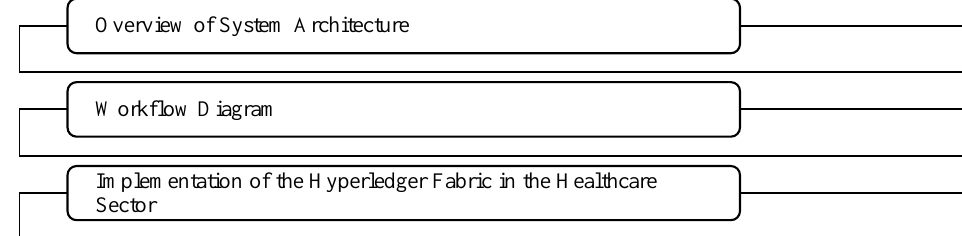
Overview of System Architecture